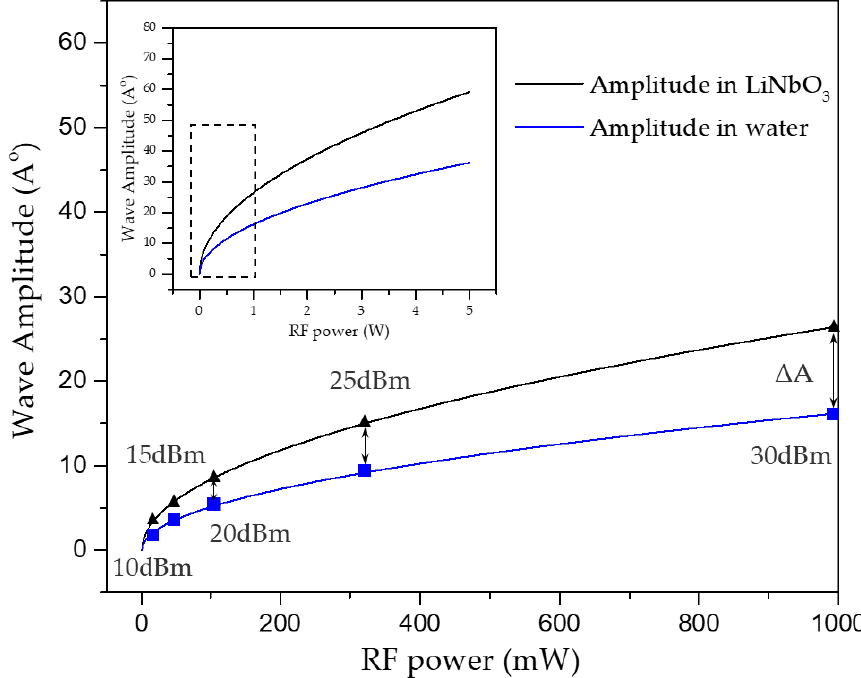
Figure 3. Acoustic displacement amplitudes Â at different electrical power levels inside the piezo- electric substrate and droplet, respectively. The frequency of the excitation acoustic wave is constant at 99.1 MHz.